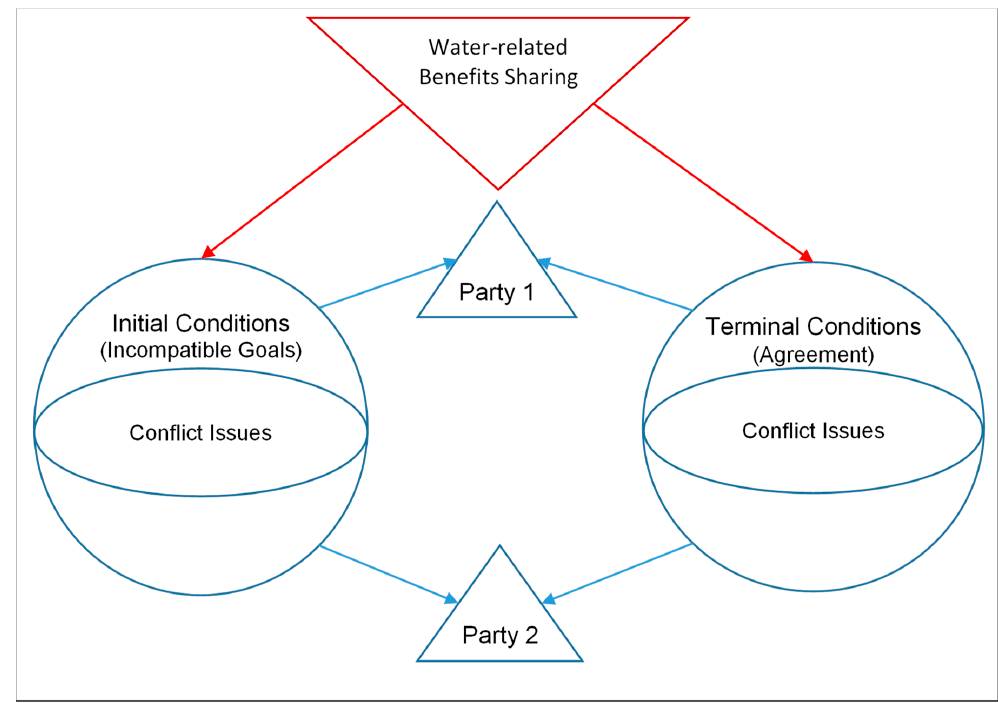
Figure 8. Structure of Benefit-Sharing Mechanism. Table 7. Benefit-sharing Mechanism—Theory and Implementation.